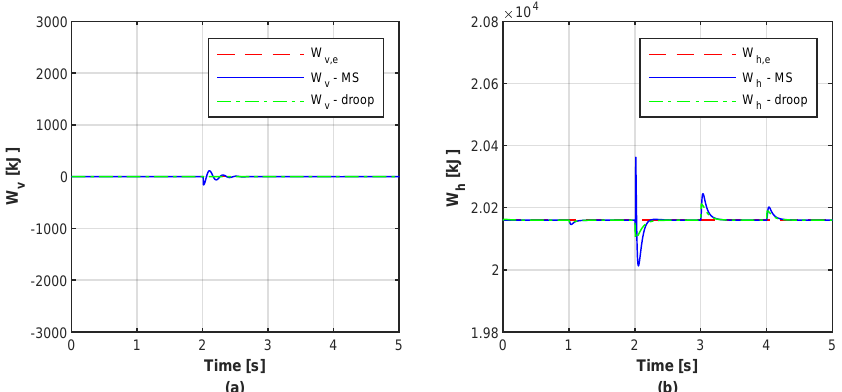
Figure 14. Energy dynamics response from the master terminal: ( a ) energy difference W v ; ( b ) total energy W h .